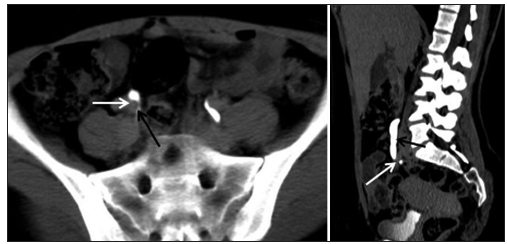
FIGURE 2. In late venous phase contrast-enhanced CT, axial and sagittal- oblique images show the right distal ureter (black arrow) compressed by the right external iliac vein (white arrow).